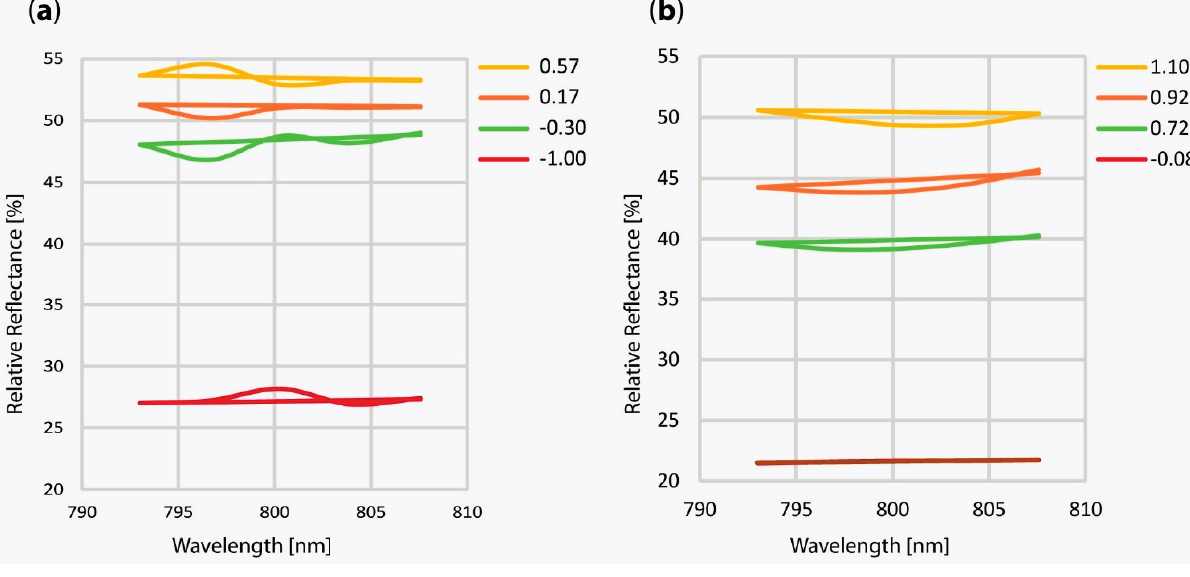
Figure 8. A comparison between four image spectra with and without applying R-L deconvolution. ( a ) Image spectra from the simple run (without R-L deconvolution); and ( b ) image spectra from the full approach (including R-L deconvolution). The legend values represent the absorption depth (difference between the absorption band at 803 nm and its corresponding value in the continuum). Deconvolution has a high potential for mapping the exact borders of these zones, especially for transition pixels at the outer zones of the REE-enriched parts. Modified after Boesche et al. 2014